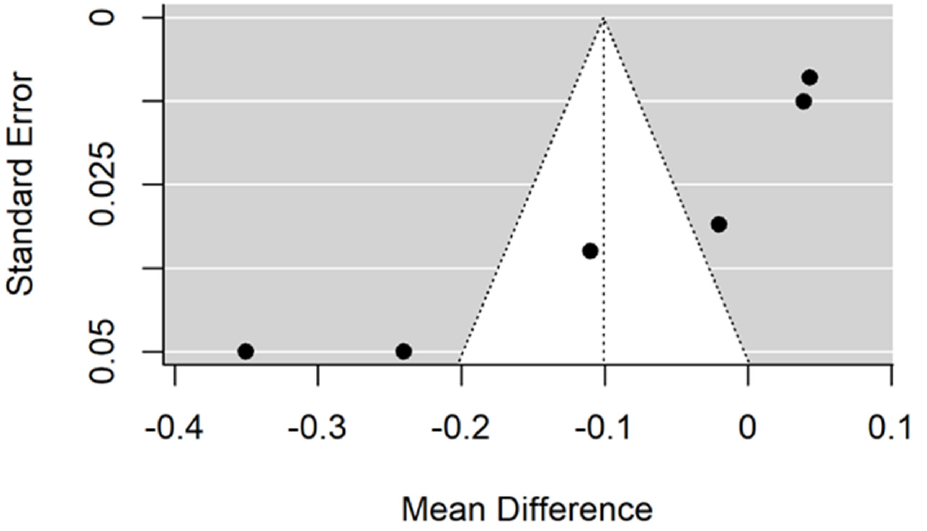
Figure 7. Funnel plot for evalutaion of thread depth dimension infulence on pull-out strentght in artifical bone model studies.